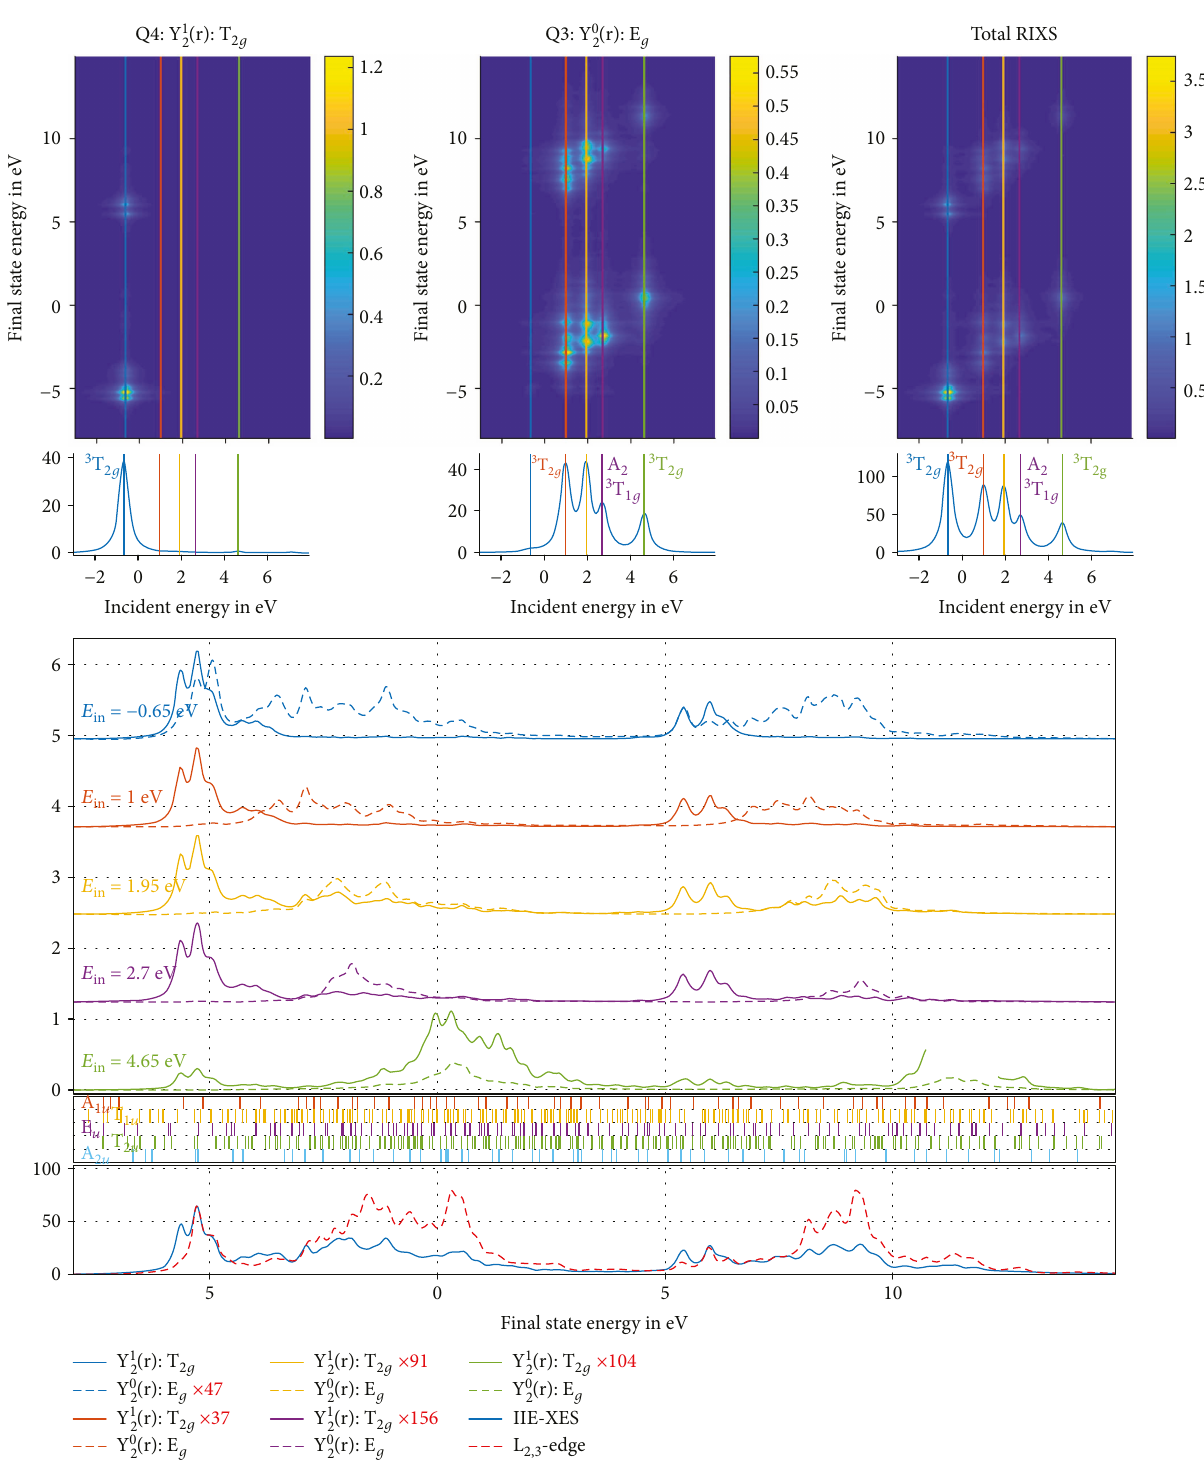
Figure 36: Calculation of 1s2p RIXS and 2p XAS for Mn 3+ ( 3d 4 ) for 10D q = 3 9eV (low